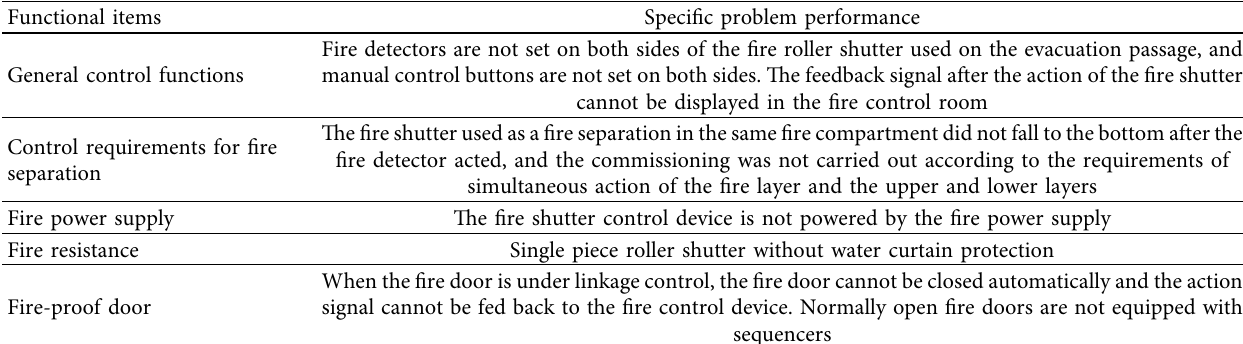
Table 10: Te problem of preventing frebox of system (source: